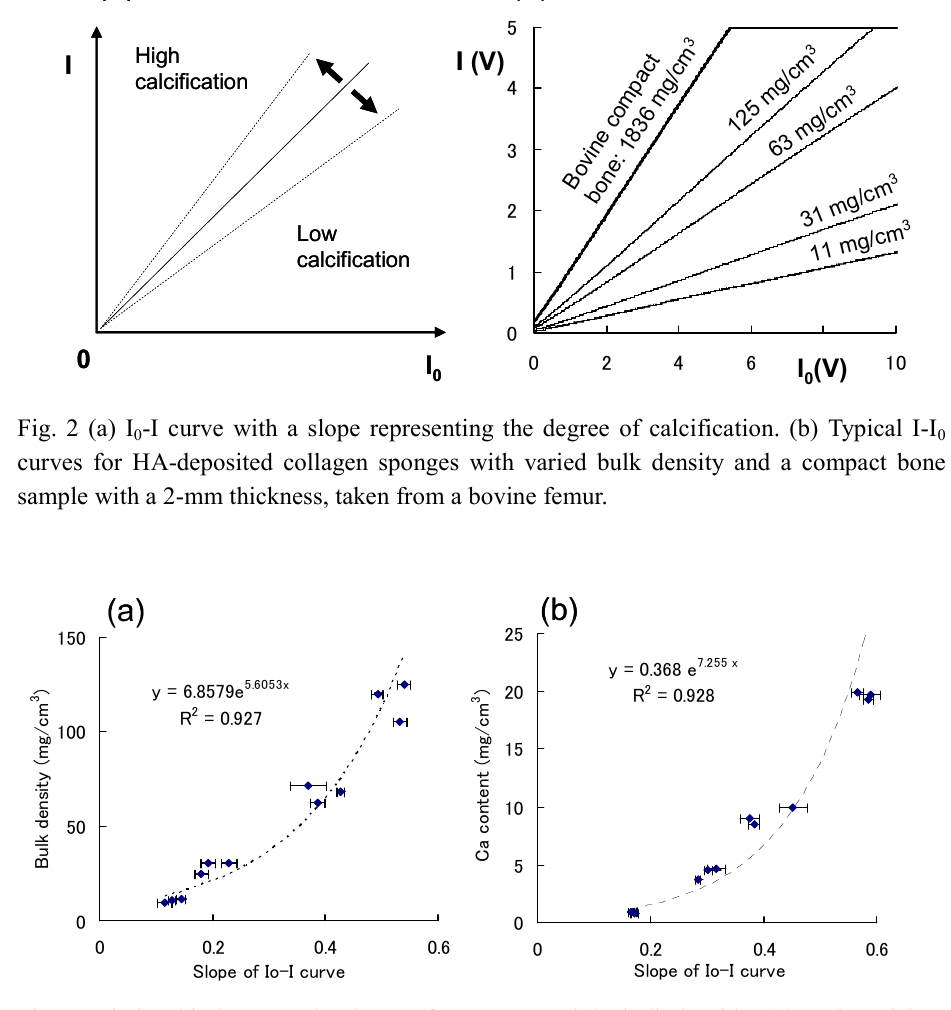
Fig. 3 Relationship between the slopes of I -I curve and the bulk densities (a) or the calcium 0 contents (b) of HA-deposited collagen sponge scaffold. Data represent the mean ± SD for six (a)- or four (b)-time